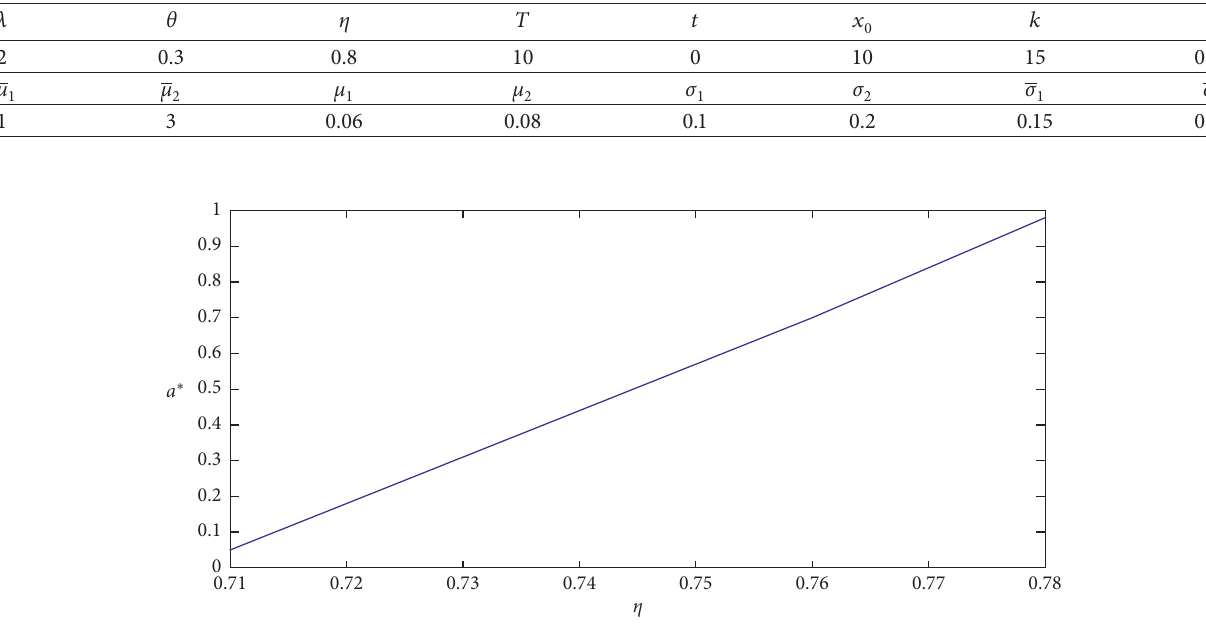
Figure 1: Effect of η on a ∗